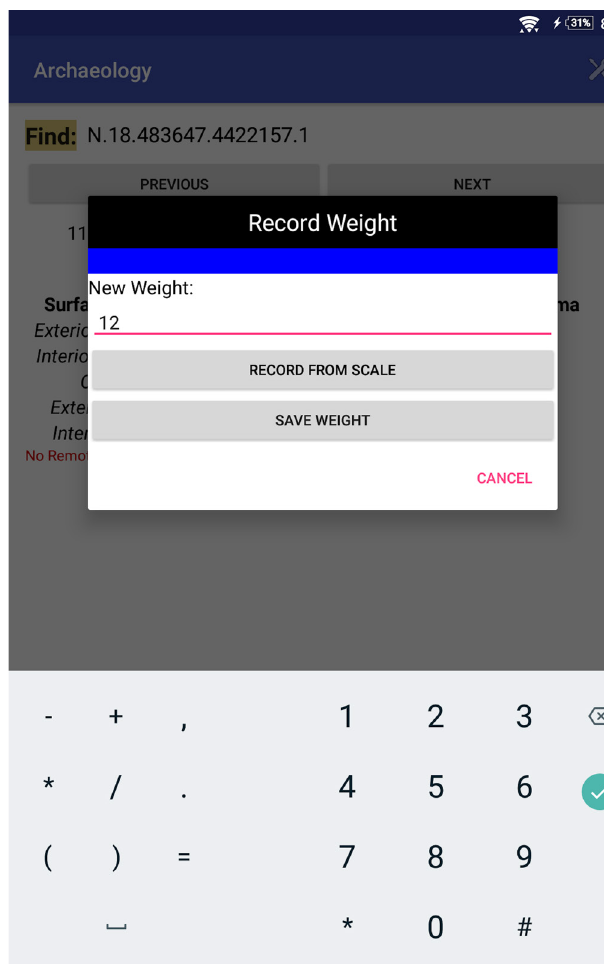
Figure 2. Screen capture of the peripheral device control app interface for a Bluetooth